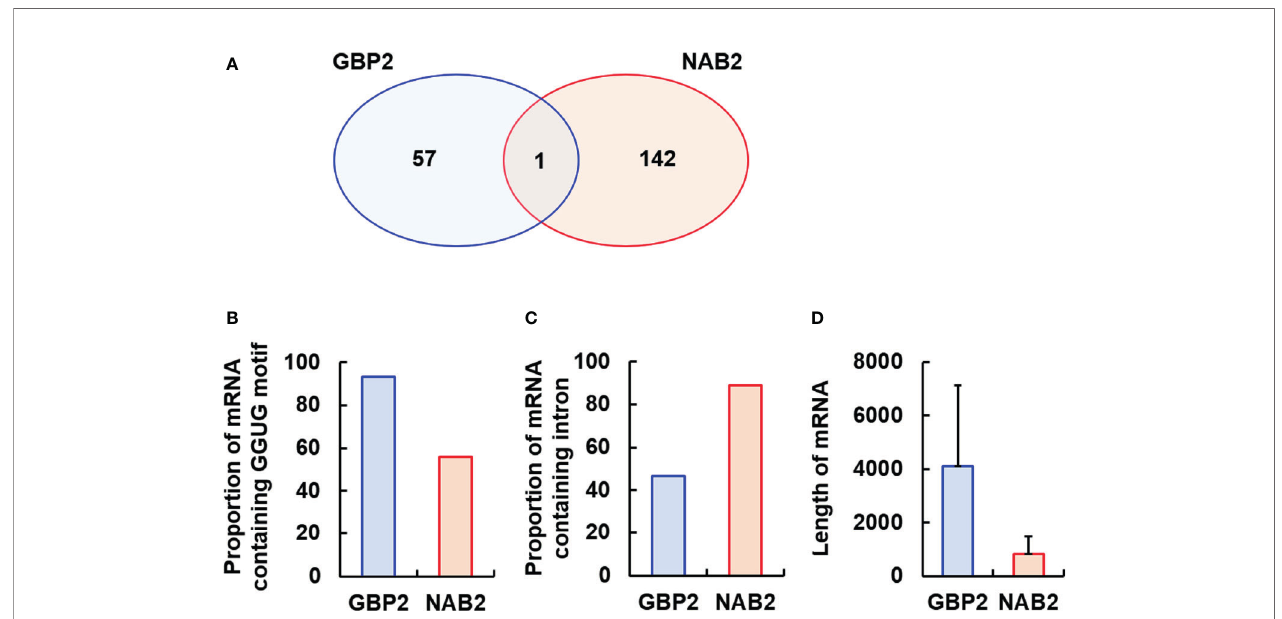
FIGURE 4 | Analysis of the mRNAs bound by GBP2 or NAB2. To analyze the mRNAs bound by GBP2 or NAB2, mRNAs exhibiting < 500 transcripts per million in experimental subjects or > 500 transcripts per million in control subjects were excluded. (A) Venn diagram of mRNA sequences detected by RNA immunoprecipitation coupled to RNA sequencing of GBP2::mCherry and NAB2::mCherry parasites. (B) Percentage of mRNAs containing the GGUG motif among 58 and 143 mRNAs bound to GBP2 and NAB2, respectively. (C) Percentage of mRNAs containing an intron among 58 and 143 mRNAs bound to GBP2 and NAB2, respectively. (D) Length of 58 and 143 mRNAs bound to GBP2 and NAB2, respectively. Results are means ± standard